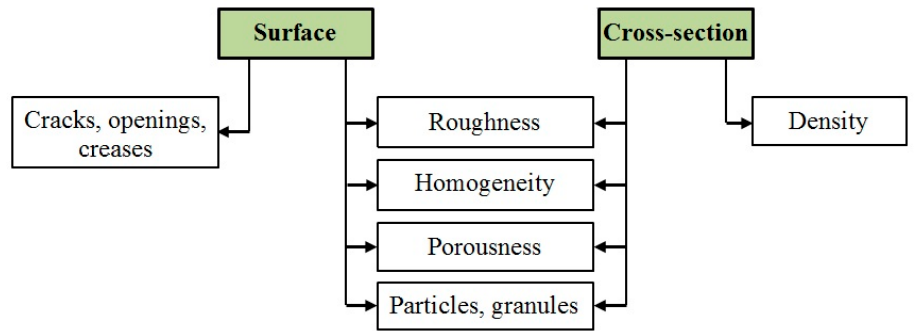
Figure 17. Characteristics of the film structure determined by SEM.